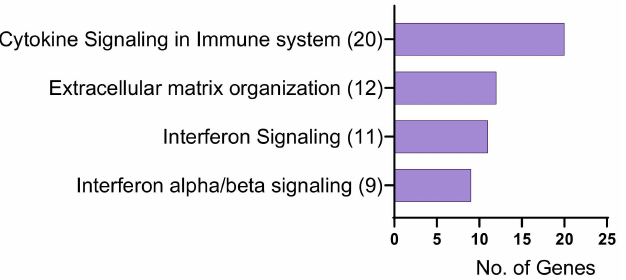
Figure 6. Reactome pathway analysis for significant differentially expressed genes in KC-altered genes responsive to TGF β 1 treatment (FDR ≤ 0.05) (FDR ≤ 0.05). Numbers in brackets are the number of genes involved in each